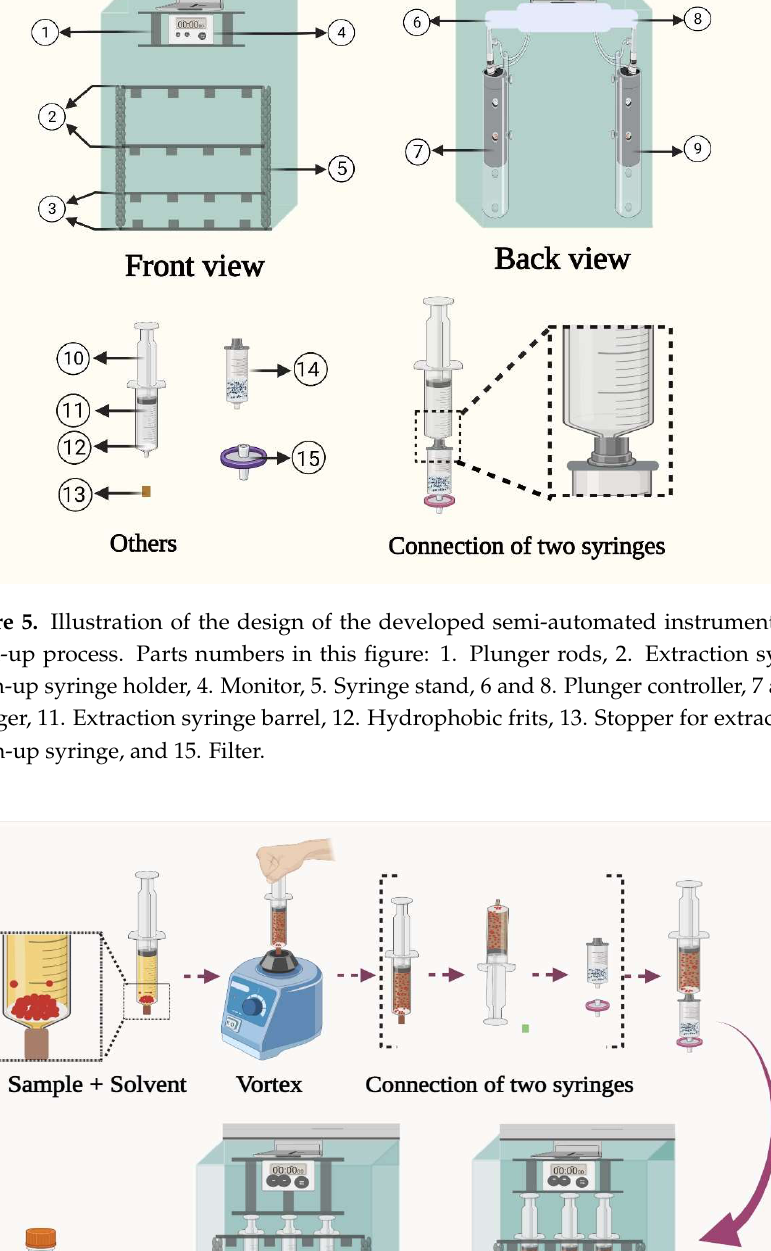
Figure 5. Illustration of the design of the developed semi-automated instrument for the FaMEx clean-up process. Parts numbers in Figure 5: 1. Plunger rods, 2, Extraction syringe holder, 3. Clean- up syringe holder, 4. Monitor, 5, Syringe stand, 6 and 8. Plunger controller, 7 and 9. Motor, 10. Plunger, 11. Extraction syringe barrel, 12. Hydrophobic frits, 13. Stopper for extraction syringe, 14. Clean-up syringe, and 15. Filter.